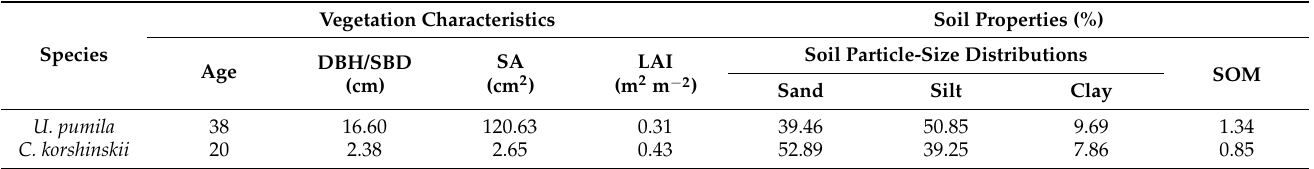
Figure 1. Geographical research sites in this study, namely, the ( a ) U. pumila site and ( b ) C. korshinskii site on the Bashang Plateau. Table 1. Detailed information about vegetation characteristics and soil properties of U. pumila and C. korshinskii stands.